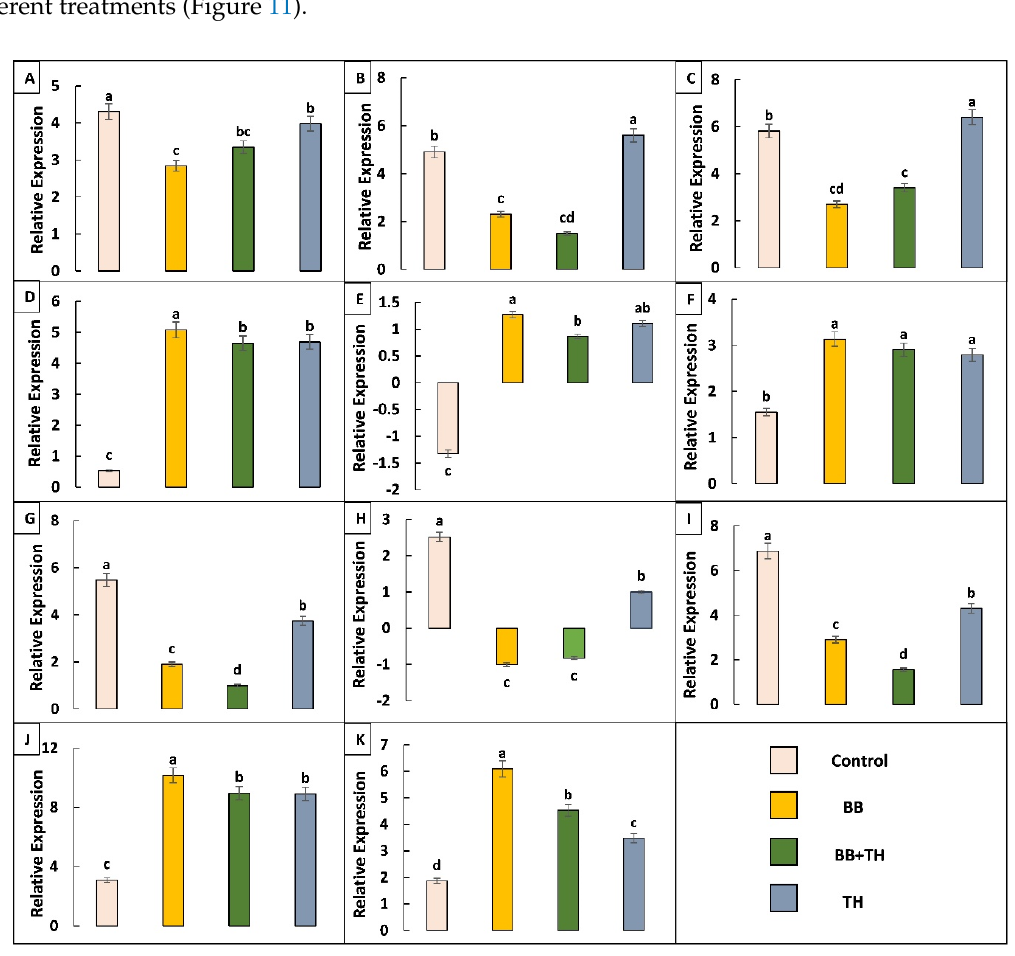
Figure 11. The qRT-PCR analysis of selected differentially expressed genes to confirm expression patterns indicated by RNA-sequencing. UDP-glucuronosyltransferase gene-LOC114350074 ( A ); larval/pupal rigid cuticle protein gene-LOC114366353 ( B ); larval/pupal rigid cuticle protein 2 gene-LOC114366367 ( C ); ABC transporter 1 gene-LOC114354308 ( D ); ABC transporter 2 gene- LOC114353130 ( E ); cadherin gene-LOC114362562 ( F ); HSP70 gene-LOC114356221 ( G ); HSP68 gene-